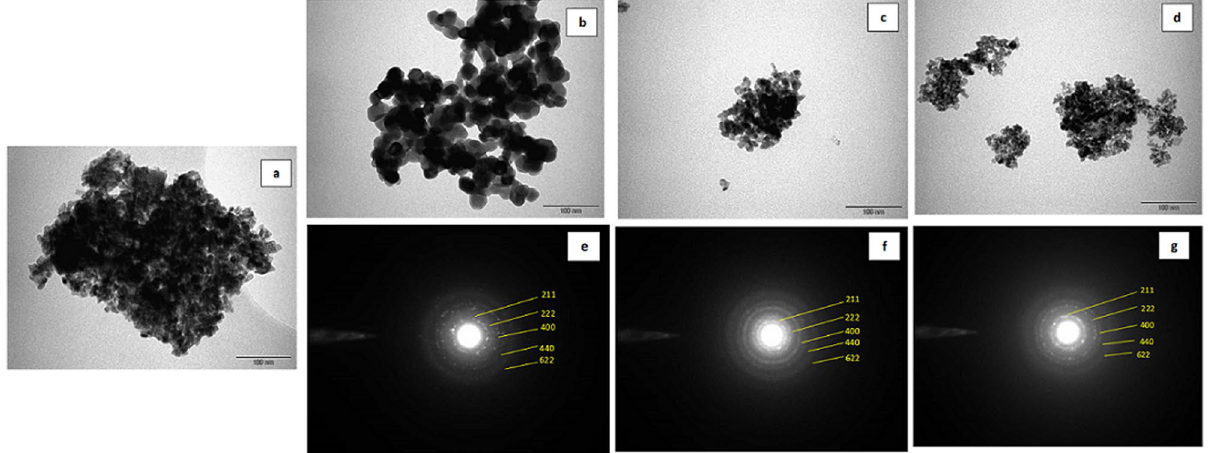
Figure 2. TEM images of ( a ) In 2 O 3 NPs, ( b ) 5%, ( c ) 10%, and ( d ) 15% Sn doped indium oxide NPs; and selected area electron diffraction (SAED) pattern of ( e ) 5% ( f ) 10% and ( g ) 15% Sn doped indium oxide NPs.